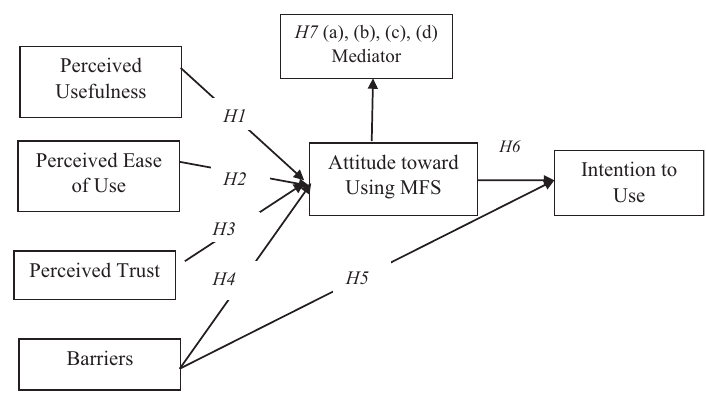
Figure 1. Research